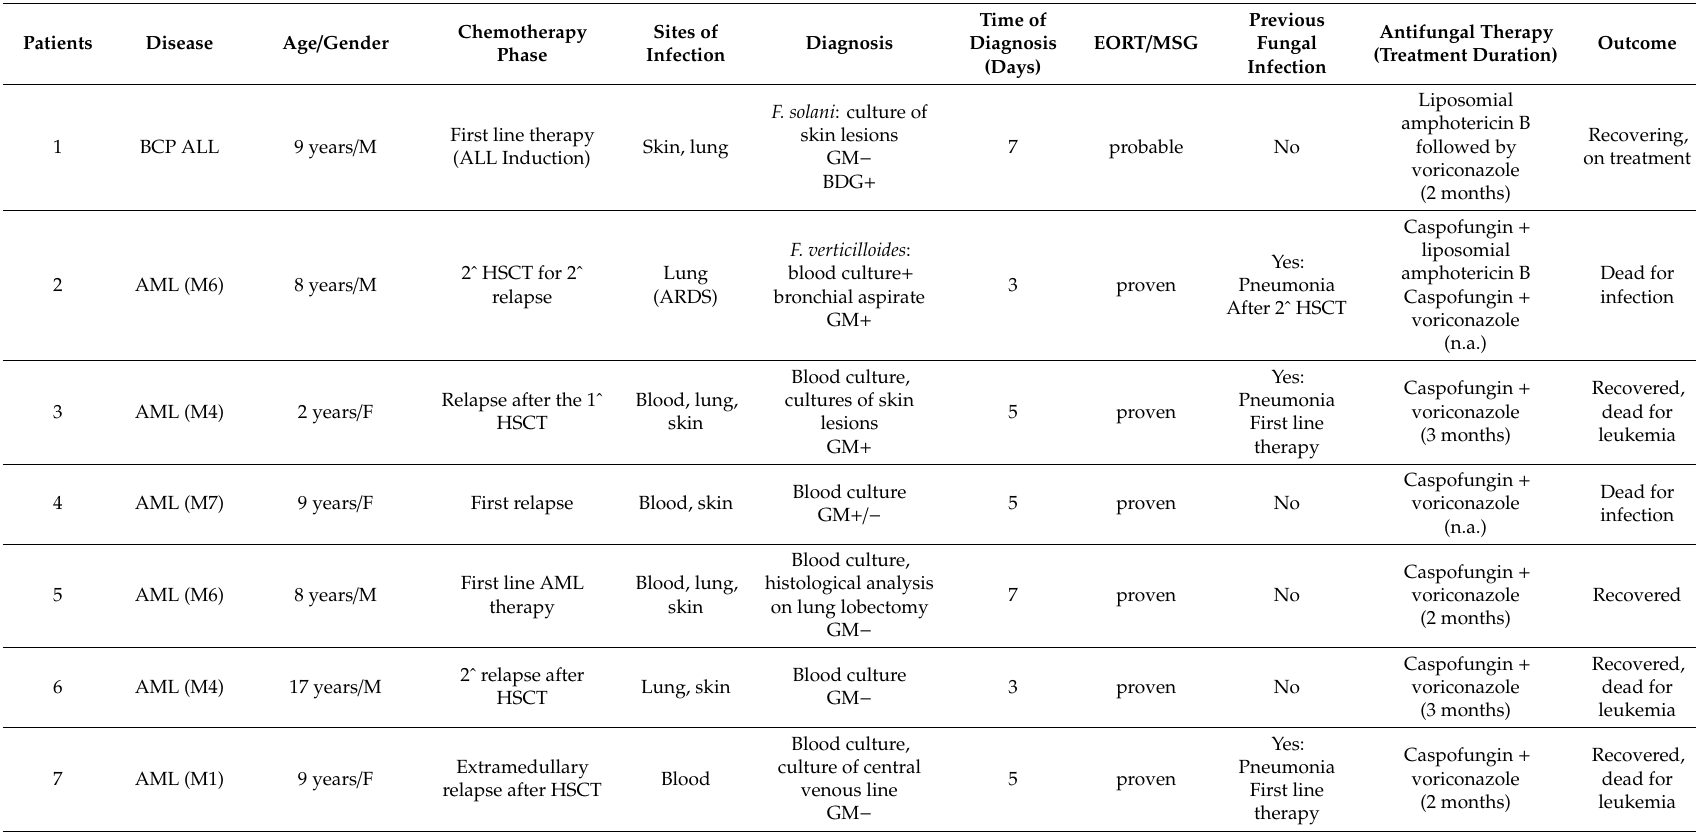
Table 1. Patients with proved diagnosis of Fusarium